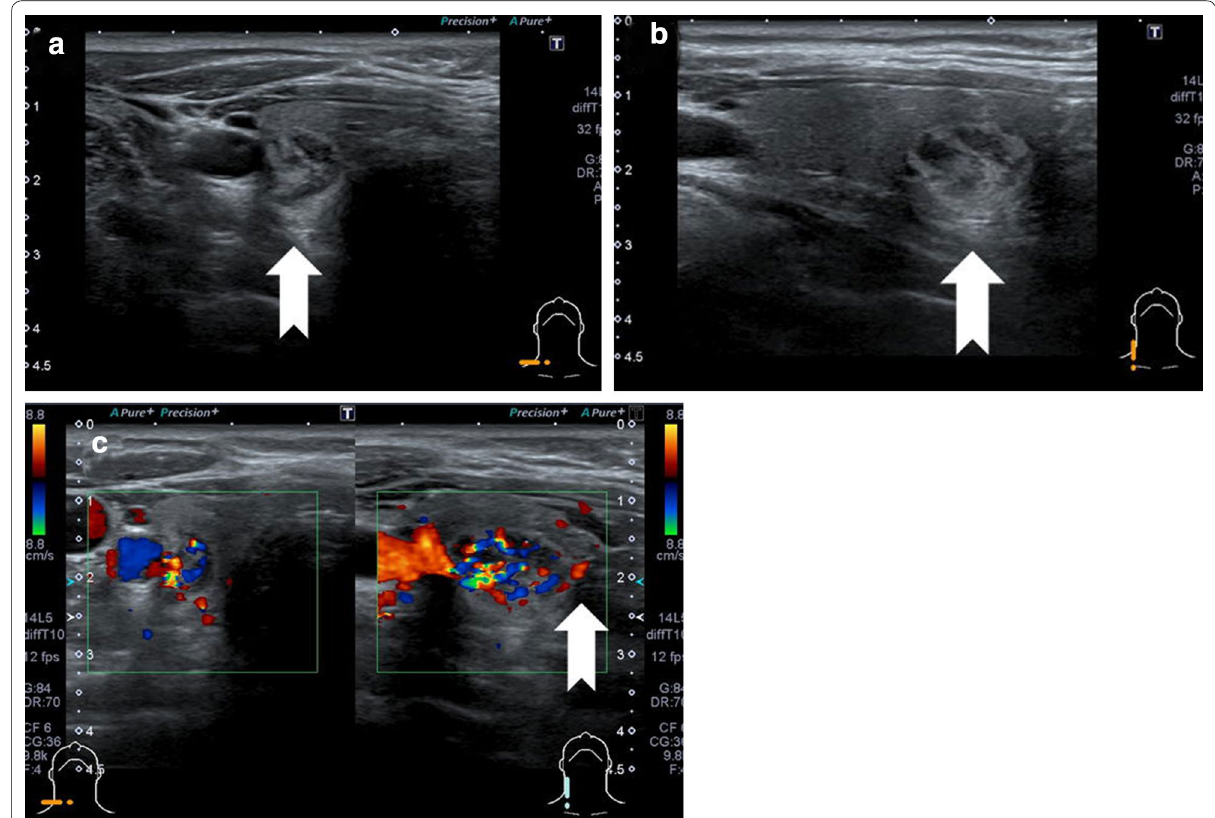
Fig. 1 Ultrasonographic imaging. a Transverse image. b Longitudinal image. c Color Doppler imaging. The tumor (( a, b ) arrow) was located in the inferior pole of the right lobe of the thyroid gland and no parathyroid mass was observed. The size of the tumor was 18 (anteroposterior transverse craniocaudal dimension). The tumor had an irregular round shape and showed heterogeneous hyperechogenicity × × with a defined margin, but within it, there were a few unclear margins, irregular and hypoechogenic area, and the tumor had a mosaic appearance at first glance. Color Doppler sonography showed that the blood vessels (( c ) arrow) flowing into the tumor were thick and marked blood flow was also observed within the